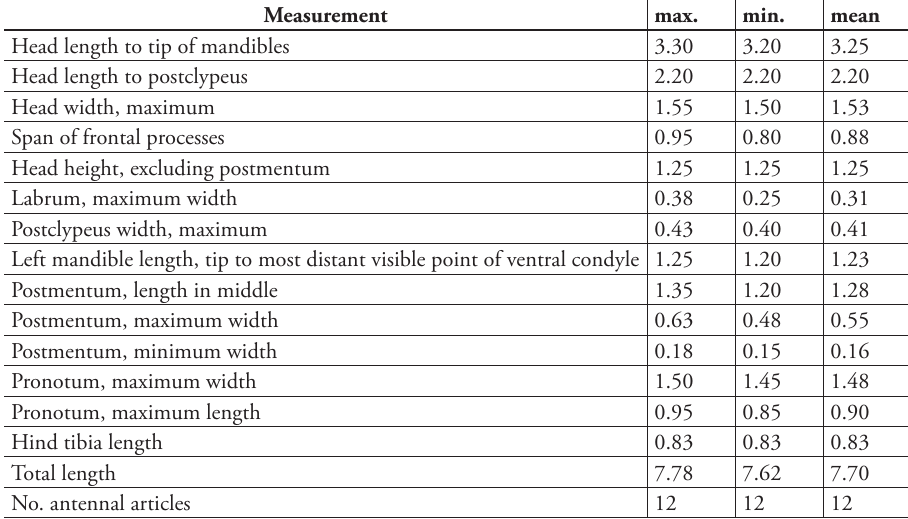
Table 4. Measurements of Neotermes agilis soldier (n=2).